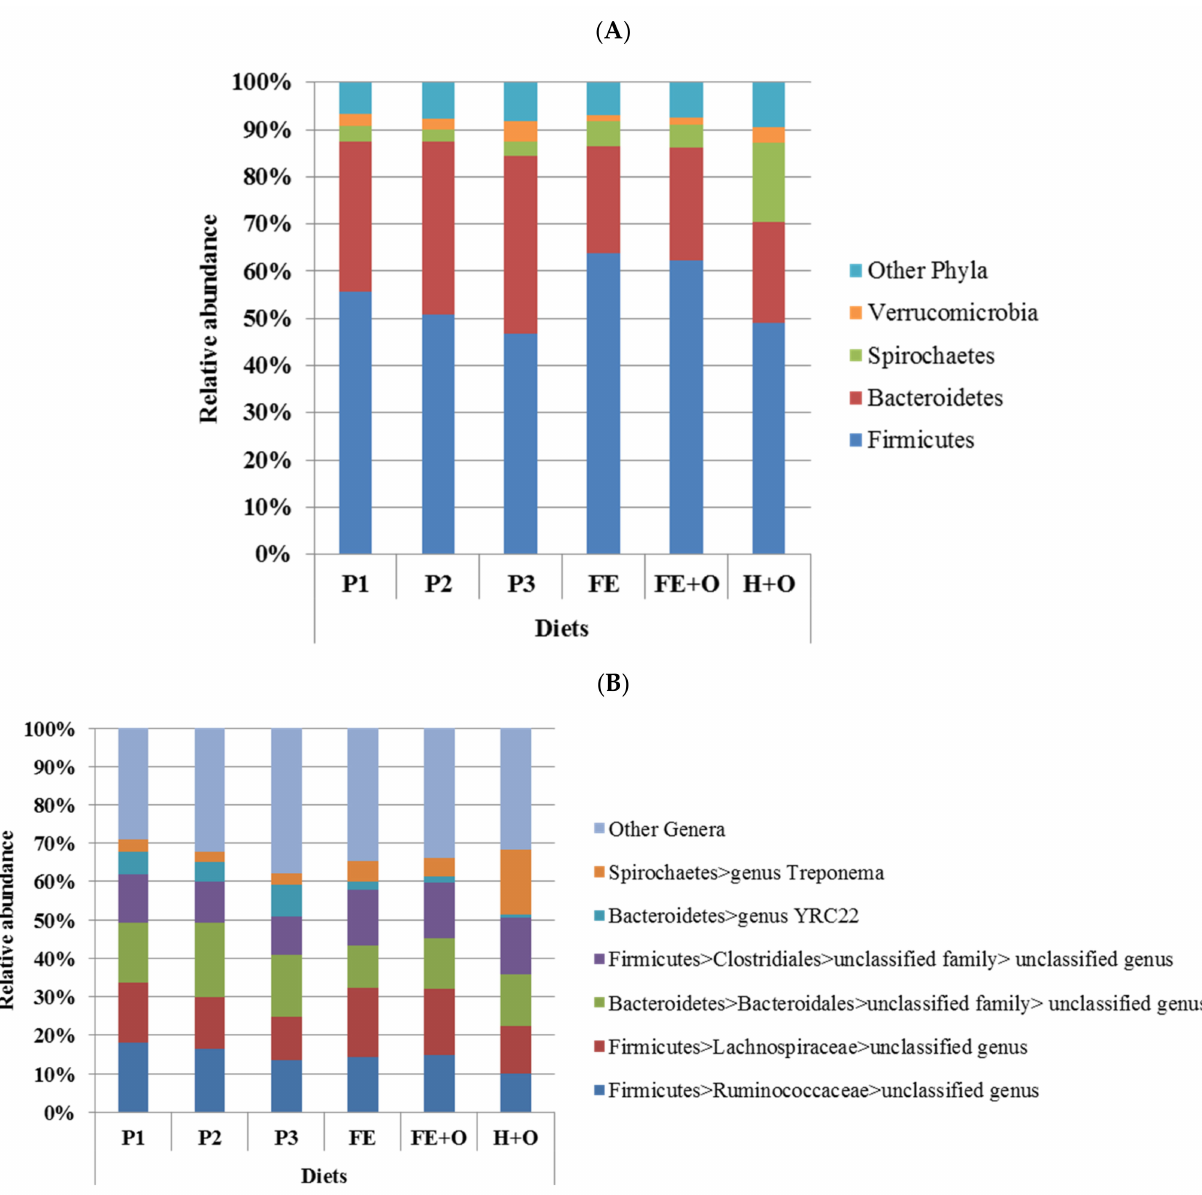
Figure 3. Mean relative abundances of the four most dominant bacterial phyla (Panel A) and six most dominant genera (Panel B) that comprised the faecal bacterial community of the six horses used in the study. Diets are represented as P1, P2 and P3 —cut pasture fed during weeks 1, 3 and 5 respectively; Diet FE—chopped ensiled Lucerne and Timothy; Diet FE + O—chopped ensiled Lucerne and Timothy fed with whole oats; Diet H + O—hay fed with whole